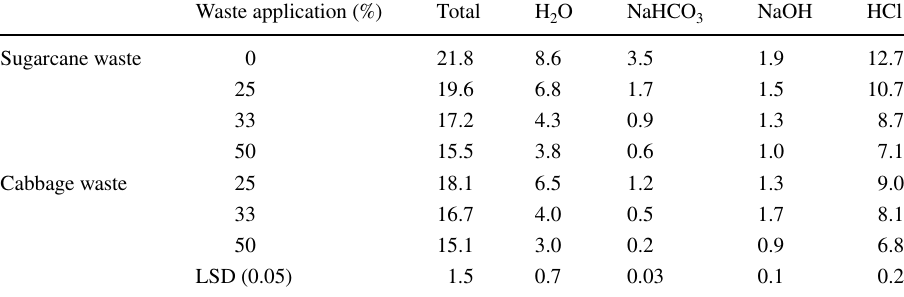
Table 3 Phosphorus fractions (g kg −1 ) in poultry litter after co-composting for 120 days with sugarcane and